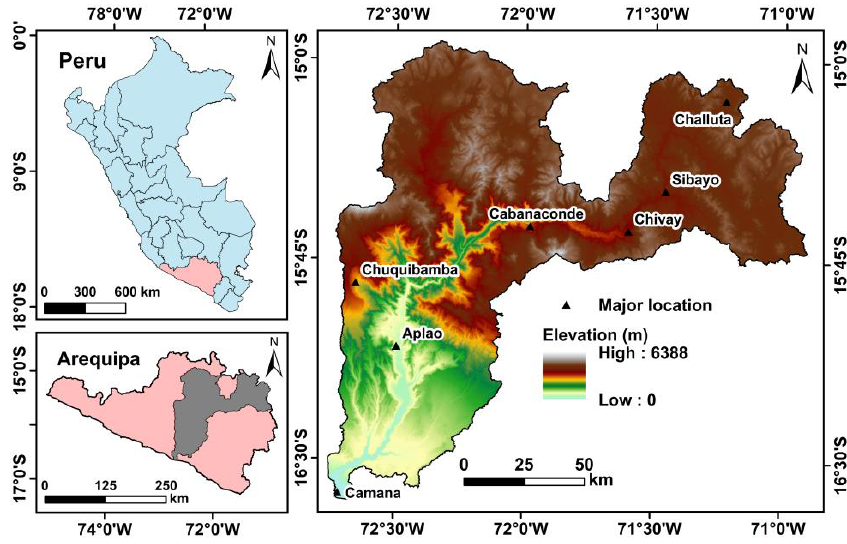
Figure 1. Geographical location and topographical variability of the study area.